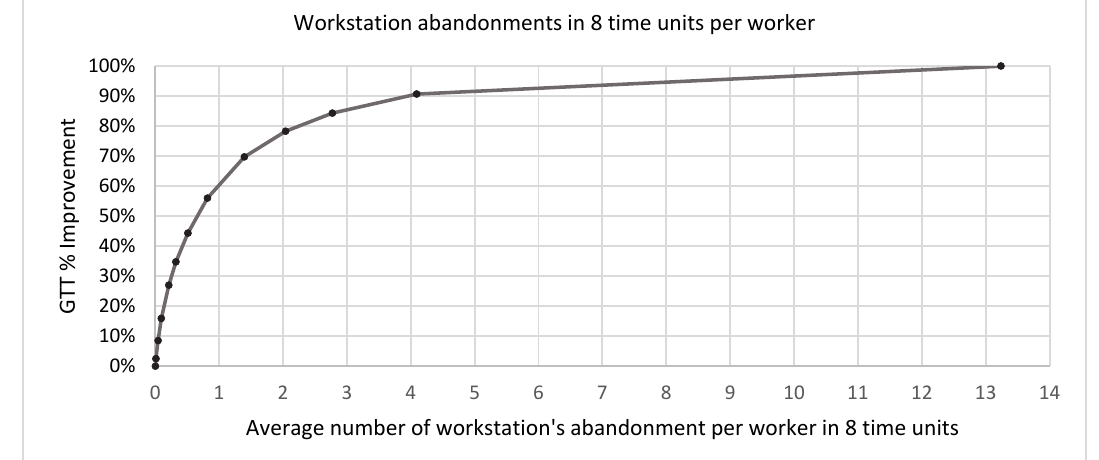
Fig. 4. GTT percentage improvement, on Y-axis, with respect to Flex1 scenario, set against the average number of workstation abandonments. The number of workstation abandonments is computed per worker in 8 time